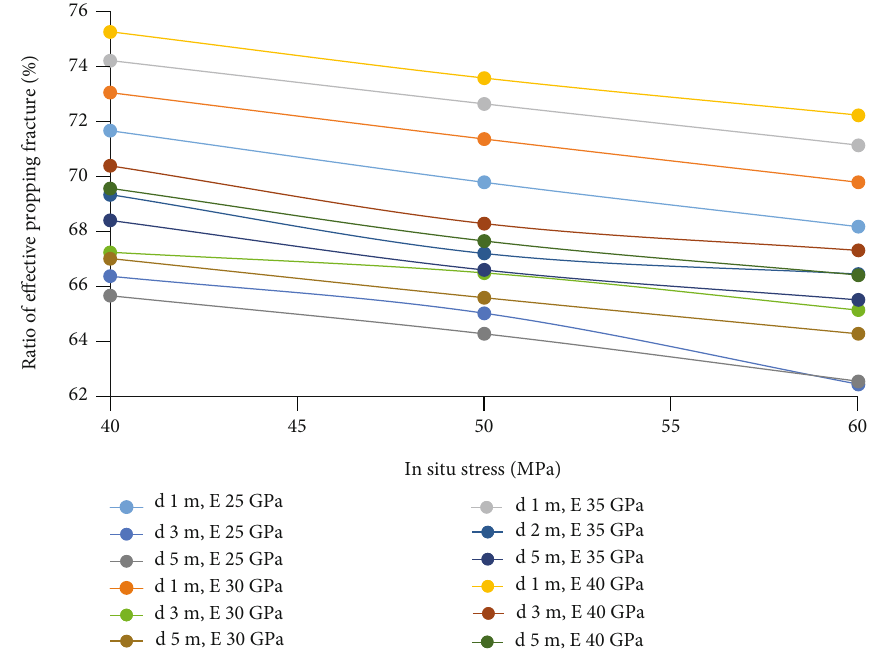
Figure 31: The proppant height is 3 mm, and the in fl uence of in situ stress under di ff erent diameters on the ratio of e ff ective supporting